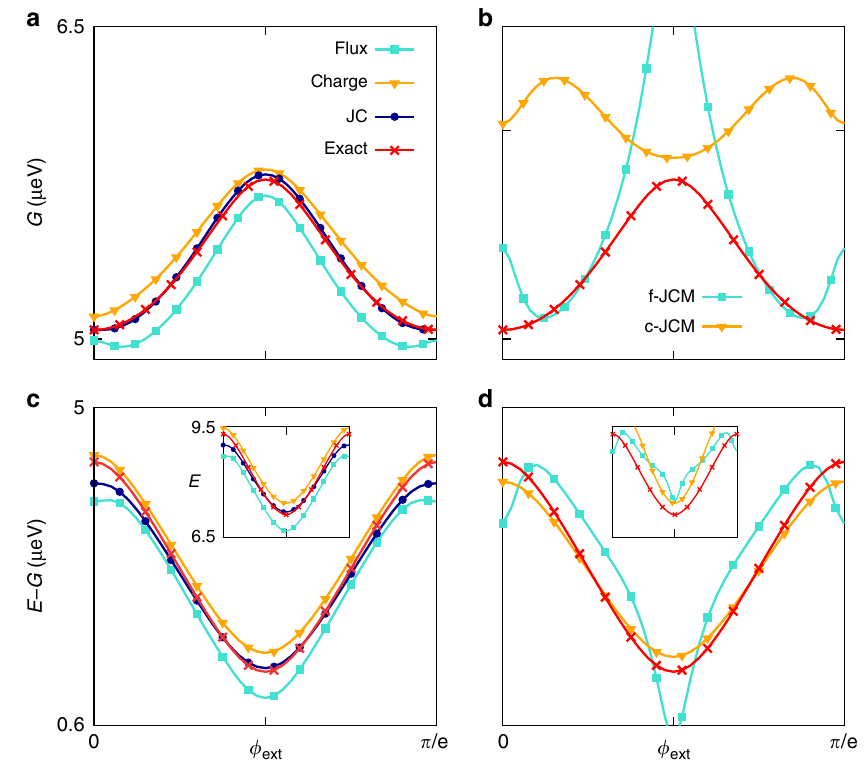
Fig. 4 Lowest energies as functions of external fl ux. In all plots, E l = 0.33 μ eV, E J = 10 E l = E c , δ = 5 and η = 0.5. a The ground energy G is plotted with ϕ ext for the fl ux-gauge and charge-gauge QRMs, for the JC-gauge two-level model and for the exact model. b For the same range as ( a ) the ground energy is plotted for the fl ux-gauge and charge-gauge JCMs that are obtained as RWAs of the corresponding Rabi models, and for the exact model. c Same as ( a ) for the fi rst transition energy E − G . The inset shows the corresponding fi rst excited energy E . The JC gauge is generally the most accurate two-level model, but because the charge-gauge QRM overestimates both the ground and excited energy, it becomes relatively accurate in the transition E − G for fl uxes away from the maximal frustration point. d Same as ( b ) for the fi rst transition energy. The inset shows the corresponding excited energies over the same range as the inset in ( c ). We see that especially in the case of the charge gauge, the JCM is inaccurate for the ground and excited energies, but it is by comparison more accurate for the